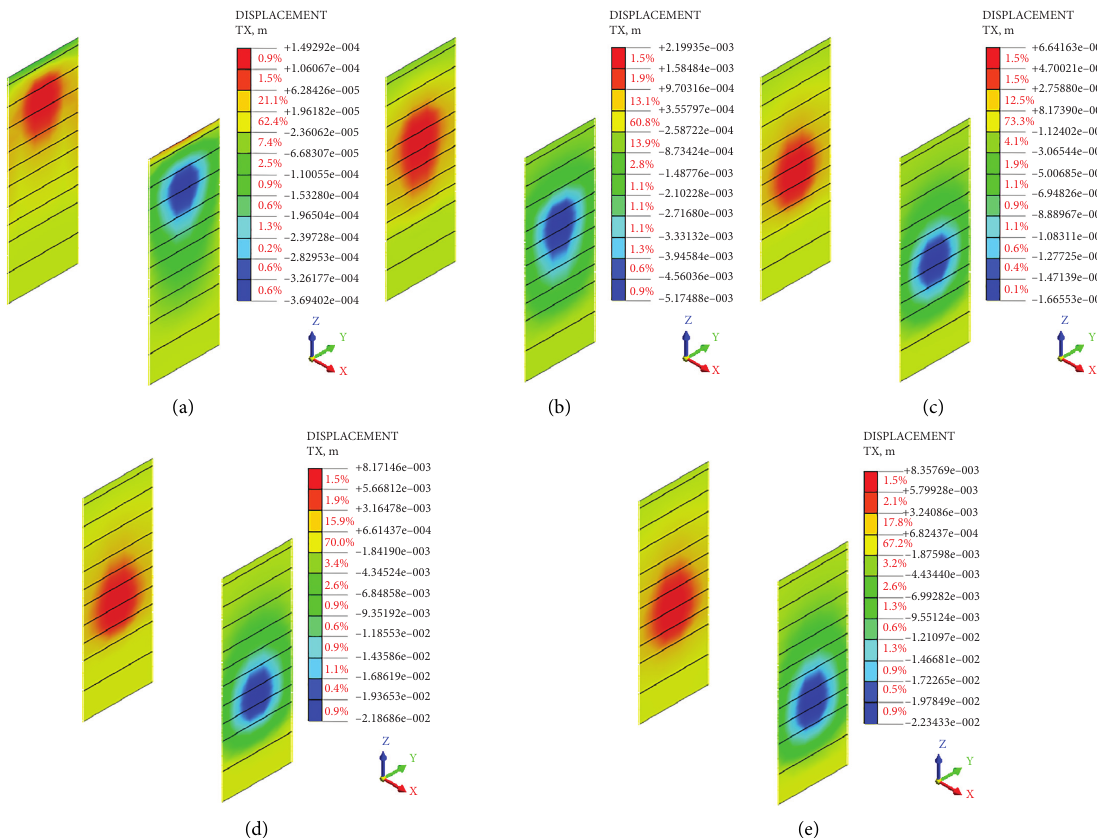
Figure 8: The horizontal displacement contour plot of the diaphragm wall with the same length under five excavation step conditions. (a) The first excavation step. (b) The third excavation step. (c) The fifth excavation step. (d) The seventh excavation step. (e) The tenth excavation step. horizontal displacement moves downward. Due to the constraint of rock on the diaphragm wall, the final max- imum horizontal displacement is above the excavation